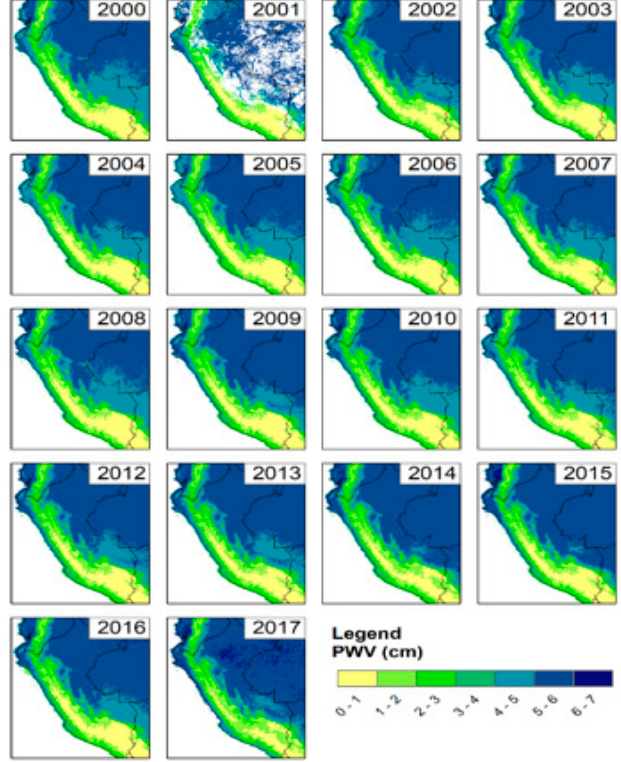
Figure 8. Spatial patterns of PWV over Peru at a yearly level (from 2000 to 2017) using MODIS product.